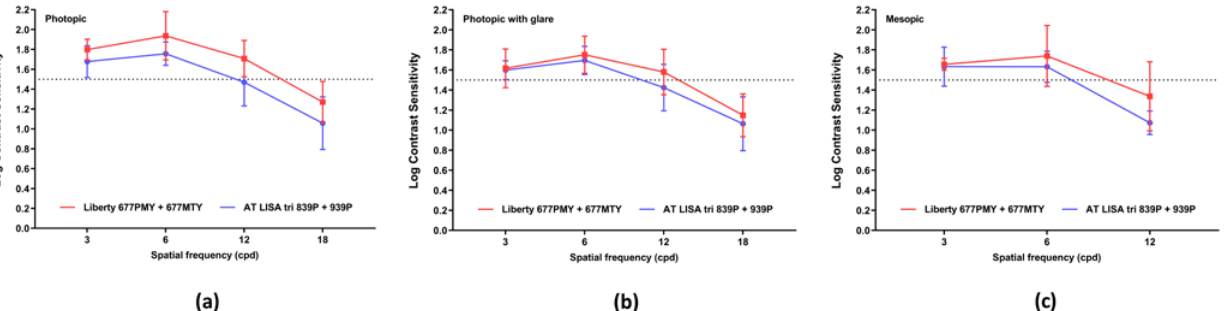
Figure 4. Contrast sensitivity, measured in different light conditions at 12 months postoperatively. ( a ) In photopic conditions. ( b ) In photopic conditions with glare. ( c ) In mesopic conditions (measurements not obtained at 18 cpd). cpd = cycles per degree.